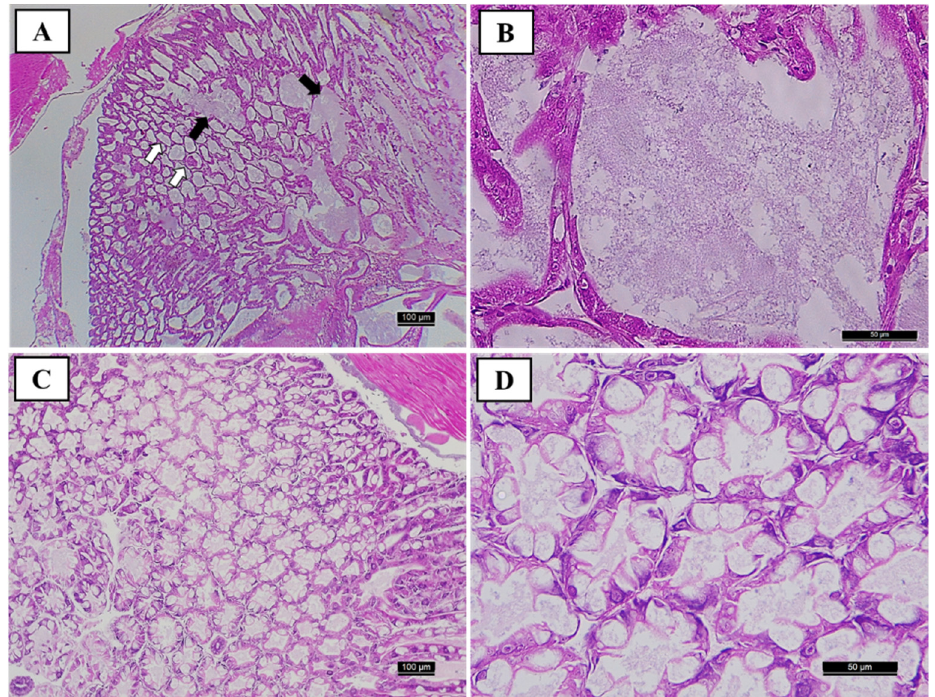
Figure 3. Histopathology examination using Davidson’s AFA-fixed tissue sections from experimental shrimp fed on frozen hepatopancreas at 46-h postinfection. Histological signs in group 1 ( Vp AHPND challenged) including tubular necrosis and cell debris are observed ( A , B ) (black arrows). Thin tubular epithelium is observed (white arrows). The hepatopancreases of group 2 (no challenge) had a normal appearance with normal cell functions ( C , D ).